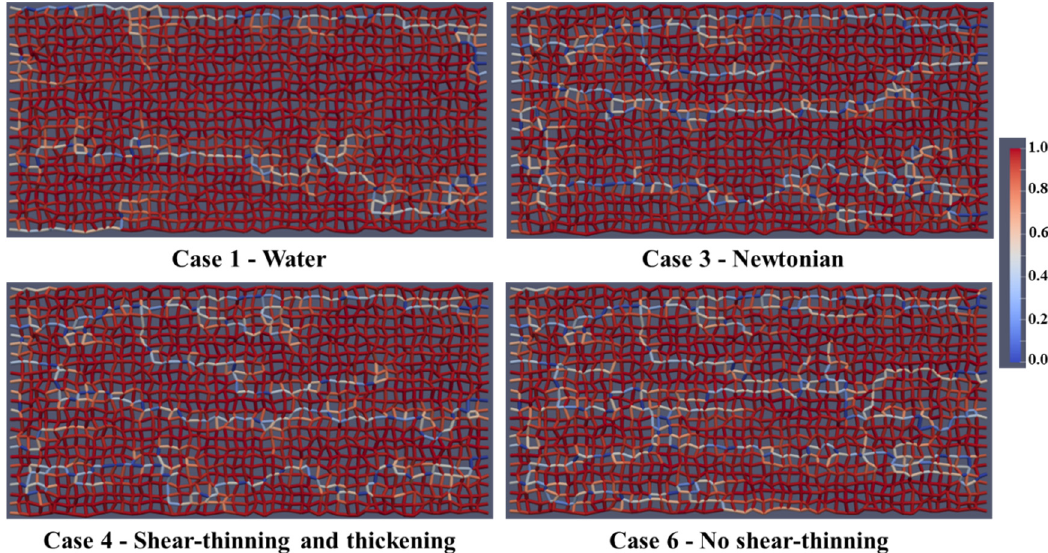
Figure 16. Fluid distribution (oil and water) after 1 PV of injected fluid with Q = 1 × 10 − 13 m 3 /s.